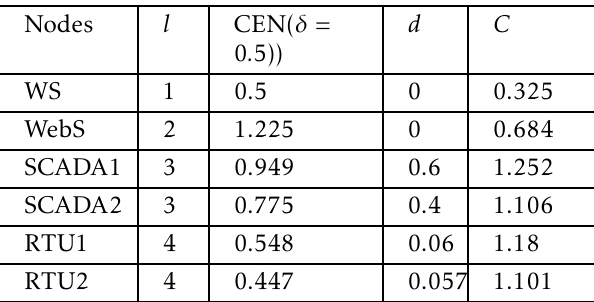
Table 4. Total Criticality